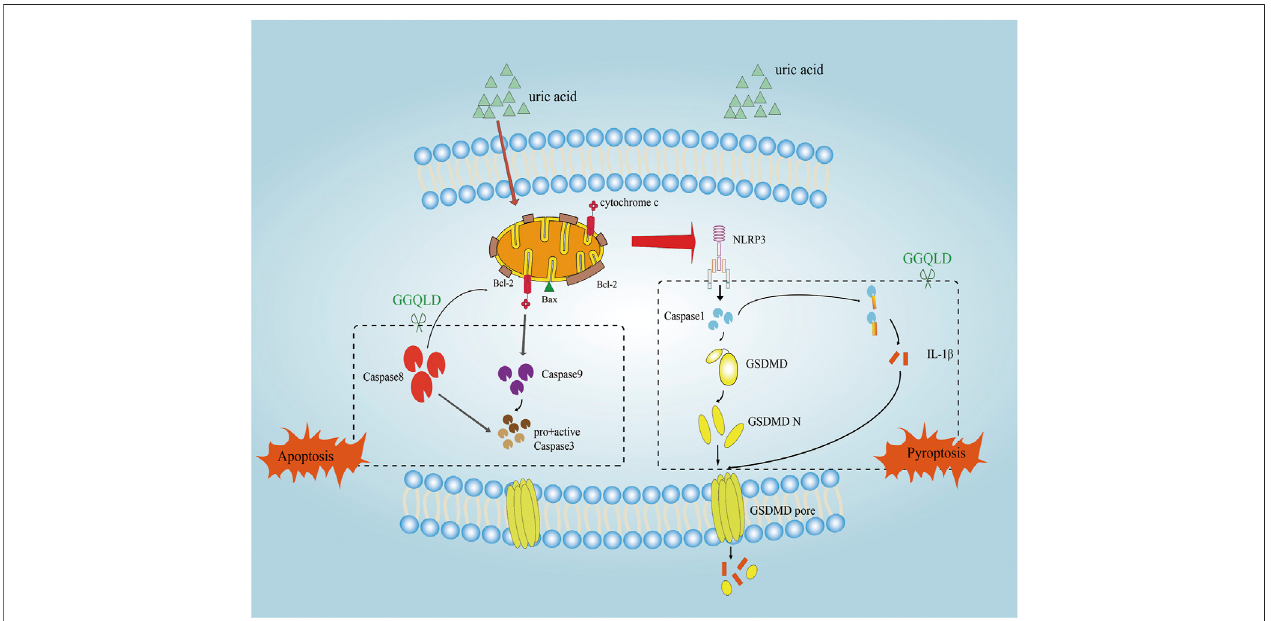
FIGURE8| ThemechanismoftheprotectiveeffectofGGQLDinHUA-inducedrenalinjury.TheincreasedUAledtoPTECmitochondrialapoptosisandassembled NLRP3 in fl ammasomes and facilitated IL-1 β maturation and thus in fl amed the cells, which damaged the mitochondria and caused pyroptosis to lead to renal tubule damage. GGQLD protected cells from inhibiting the mitochondrial apoptotic pathways through capsase-9, caspase-8, and Bcl-2/Bax/caspase-3, thus alleviating in fl ammation via inhibition of NLRP3/caspase-1/IL-1 β /GSDMD.